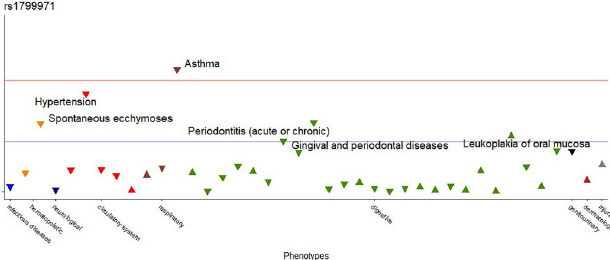
Fig 3. PheWAS result for SNP rs1799971 performed with the total sample. The blue line indicates p-value < 0.05. The horizontal red line indicates the threshold of p < 0.002. The tip direction of the triangles represents the direction of the odds ratio of each association, the upward triangles indicate odds ratio � 1; downward triangles indicate a protective effect (odds ratio < 1.0). The different colors of the triangles indicate different disease groups.